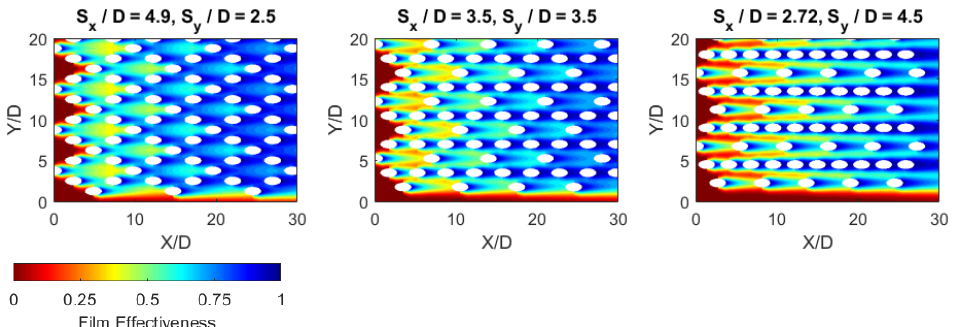
Figure 9. Film effectiveness contours for TD2 and two film spacing variations, for M = 0.30. TD2 ( S x = S y = 3.5) is the central